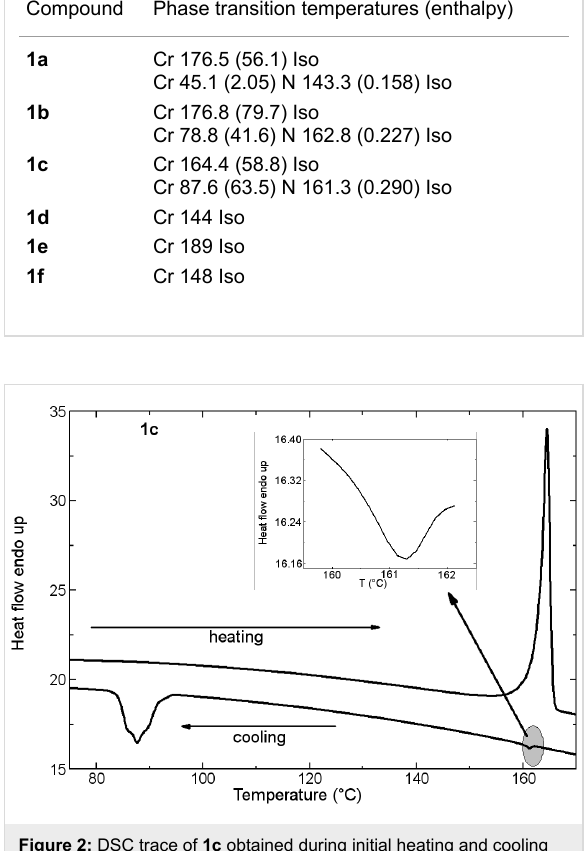
To gain an understanding of the structure–property relationship we synthesized other homologues of the same core with varia- tions in the position of the chloro substituent, or without any substituent. The unsubstituted homologue 1d with a terminal n -octyloxy chain did not exhibit mesomorphism. Similarly, in cases where the chloro substituent was shifted to the 4-position, the compound 1e , with a n -hexyloxy terminal chain, or its higher homologue with a n -hexadecyloxy chain 1f , did not ex- hibit mesomorphism. It is surprising that the aspect ratio of all compounds is almost the same, but the compounds with a trans- verse chloro substituent exhibit monotropic nematic phases, while the other homologues with a lateral dipole did not exhibit mesomorphism. In general, the monotropic behaviour was often considered as kinetically unstable, and hence it could occur when the aspect ratio of the molecule was not appropriate. Further investigations are in progress to understand the reasons for such